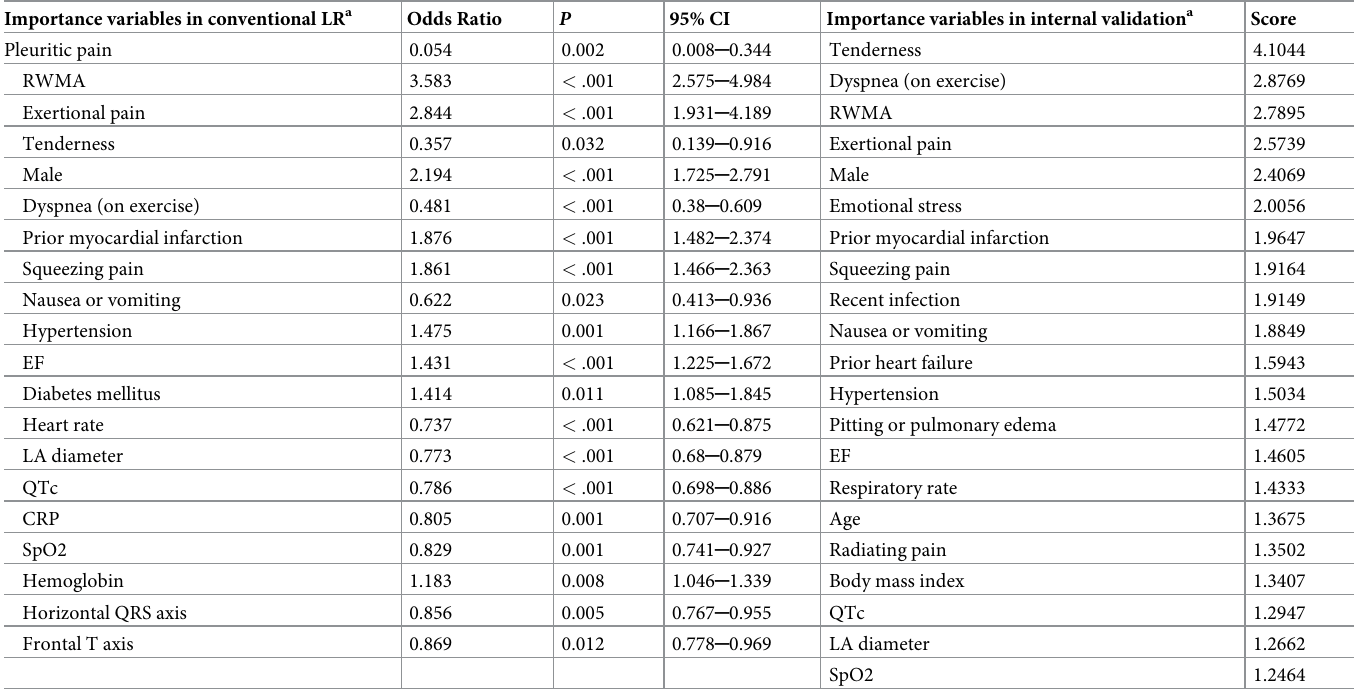
Table 4. Comparison of importance variables in conventional logistic regression and machine learning as multivariable